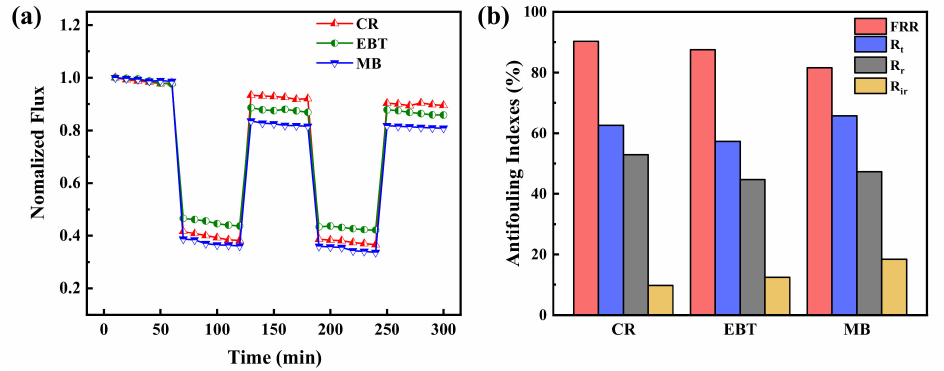
Figure 9. ( a ) The time-dependent normalized flux during the filtration of CR, EBT and MB solution and ( b ) antifouling indexes for the PES/Fe-TA3h